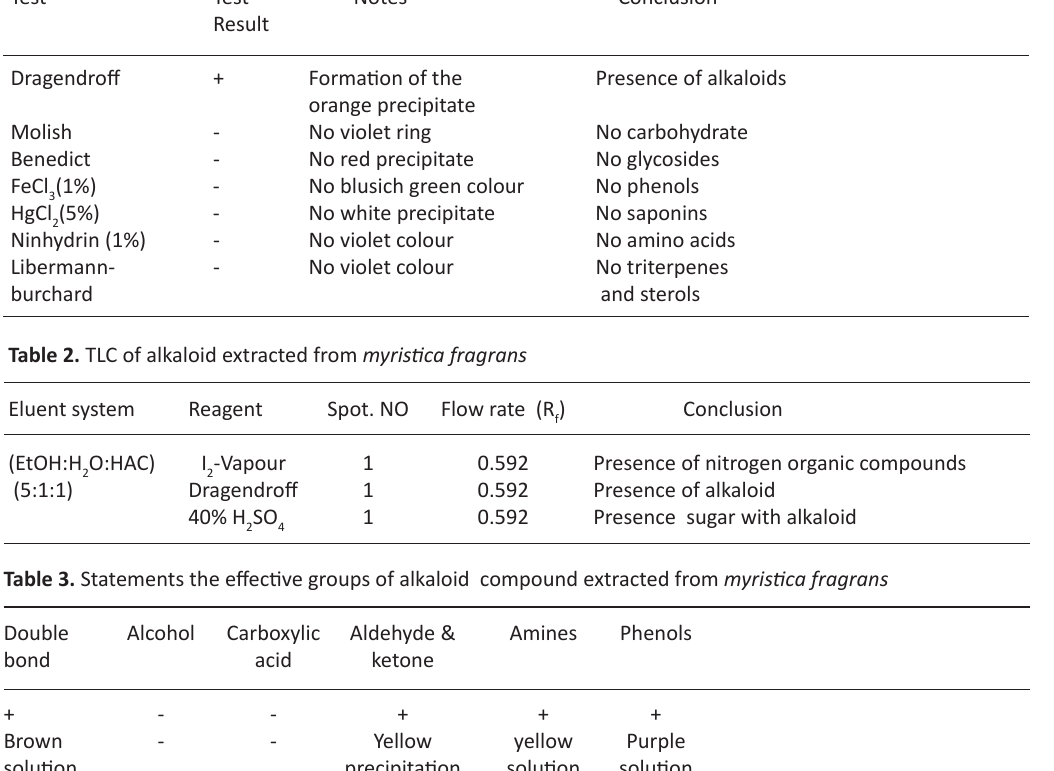
Table 1. Preliminary qualitative test for isolated alkaloids Test Test Notes